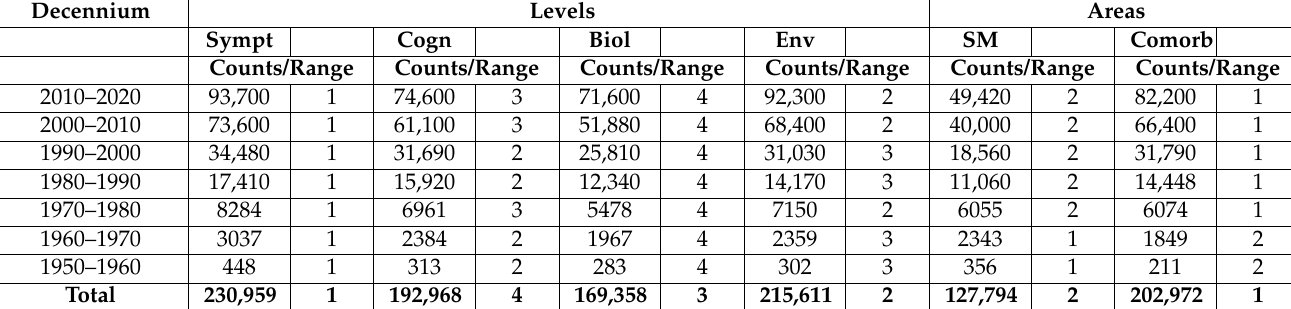
Table 3. Counts: Levels and